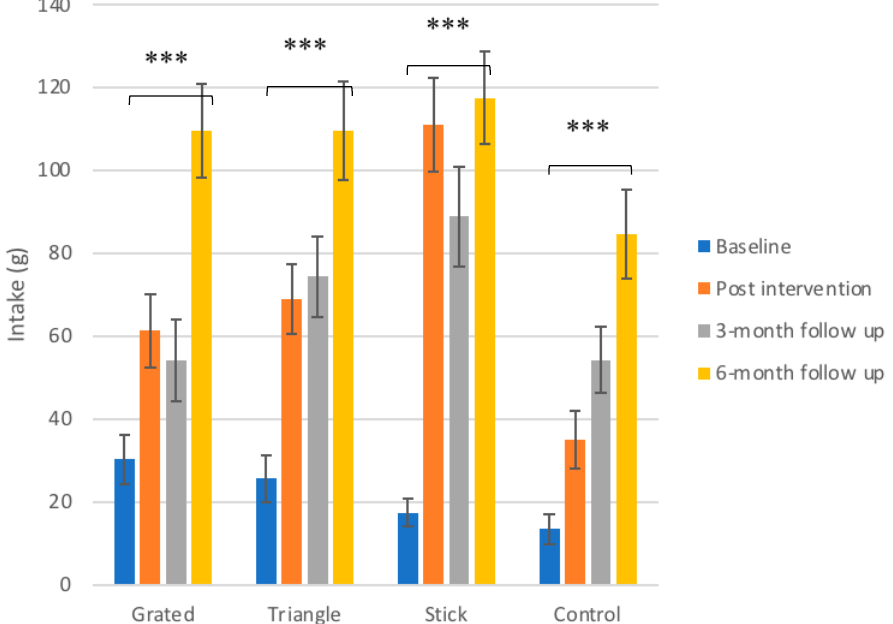
Figure 2. Mean intake scores of daikon ± SEM in g for the three different exposure groups in the control sessions. The significance of the overall differences only (baseline to 6-month follow up) for all groups are depicted. The detailed differences and their statistical significance are given in text. Significance levels: *** p ≤ 0.001.